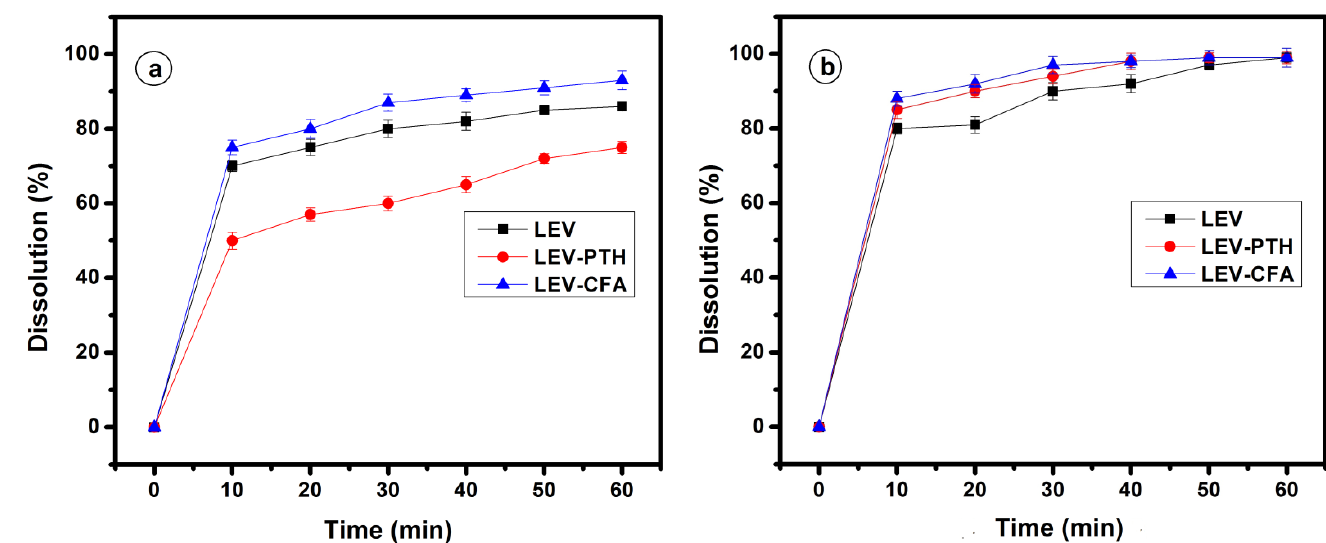
Figure 6. Powder dissolution profile of LEV, cocrystal (LEV-PTH) and amorphous salt (LEV-CFA) in dissolution mediums phosphate buffer pH 6.8 ( a ) and 0.1 mM HCl ( b ).